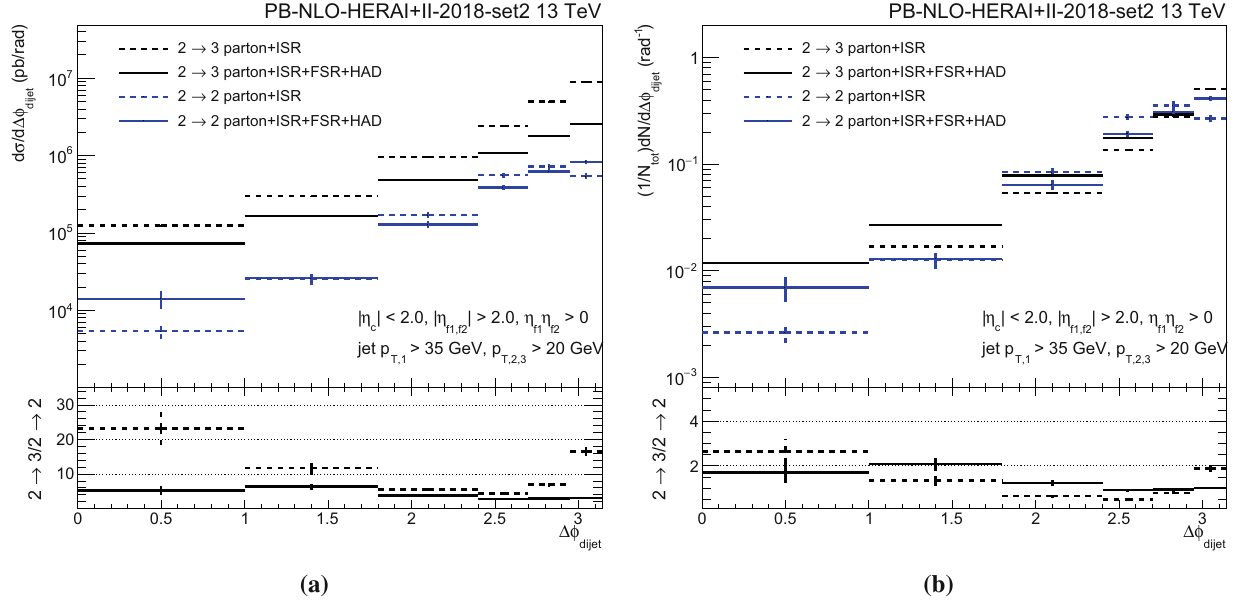
Fig. 7 Full off-shell predictions with the PB-NLO-HERAI+II-2018- set2 PDF, with initial state radiation included (dashed lines), and at hadron level (solid lines) for both 2 → 2 (blue lines) and 2 → 3 (black lines) matrix element calculations. Shown in absolute cross sections ( a )